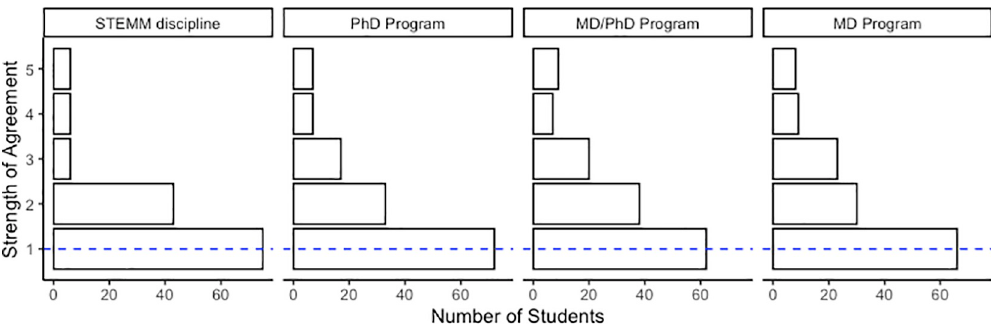
Fig 1. The Virtual VSSA program effectively provides participants exposure to the STEMM community. In the post- survey, participants were asked to what extent they agreed with the statement, "I learned a lot about xxx through the Virtual VSSA seminar series.” This question was posed about (A) STEM disciplines, (B) Ph.D., (C) M.D./Ph.D., and (D) M.D. programs. Students responded on a Likert scale indicating their level of agreement. The number of responses for each category is shown. The median response is indicated with the blue